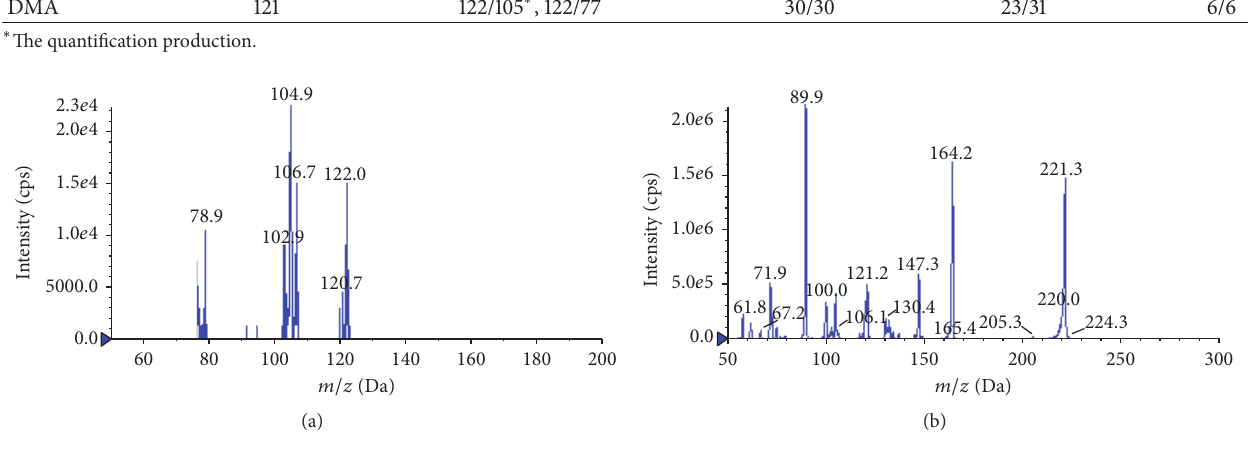
Figure 4: The MS scan spectrum of DMA (a) and xylazine (b).